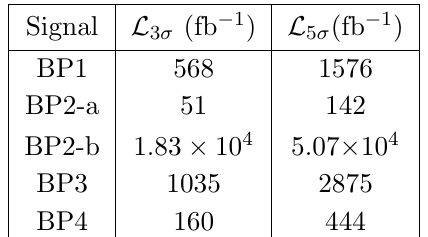
Table 11 . Required luminosities for discovery of opposite sign di-lepton + =E p s = 13 TeV